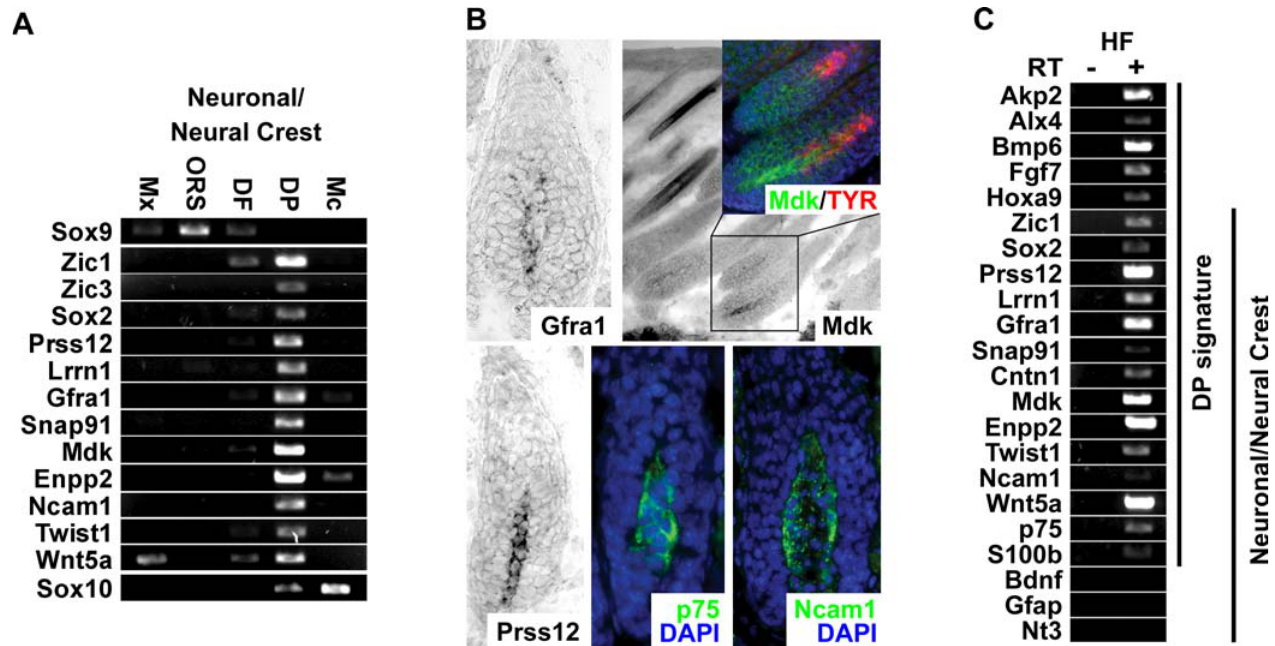
Figure 7. Neuronal and Neural Crest Genes Expressed by the DP and Hair Follicles (A) Semi-quantitative RT-PCRs were conducted as in the legend to Figure 5, except in this case, we used oligonucleotides against neuronal and/or neural crest expressed genes. In all cases, these genes either appeared on the DP molecular signature or scored as expressed by the DP as well as one or more of the other four skin populations. (see Figure 4) Shown are representative RT-PCR data, which show an excellent correlation with the DP- preferred expression pattern of the majority of these neural genes. (B) Immunohistochemistry and in situ hybridizations of neuronal/neural crest genes in skin. Sections of P4 backskins were subjected to either immunofluorescence using color-coded Abs as indicated or in situ hybridization using the indicated biotinylated cRNA probes (sense controls were negative). Merged images of serial sections were used to compare Ab (red) and in situ (pseudogreen) patterns. Gfra1 , glial derived neurotrophic factor receptor1; Mdk , midkine; Prss12 , serine protease neurotrypsin; Tyr, tyrosinase. (C) Detection of neuronal/neural crest genes in highly enriched hair follicle preparations. Highly enriched follicle preparations were isolated by serial low-speed centrifugation following dispase and collagenase digestion of P4 backskins. After isolation and preparation of their mRNAs, semi-quantitative RT-PCR was conducted using oligonucleotides to those neuronal and neural crest markers that were found in the DP signature. As controls, oligonucleotides were used against Akp2 , Alx4 , Bmp6 , and Fgf7 , which are all markers that we mapped to DP by in situ hybridizations and/or immunofluorescence (see Figure 5). Note that the neuronal/neural crest genes appearing on the DP signature showed comparable signals to the documented DP genes. DOI: